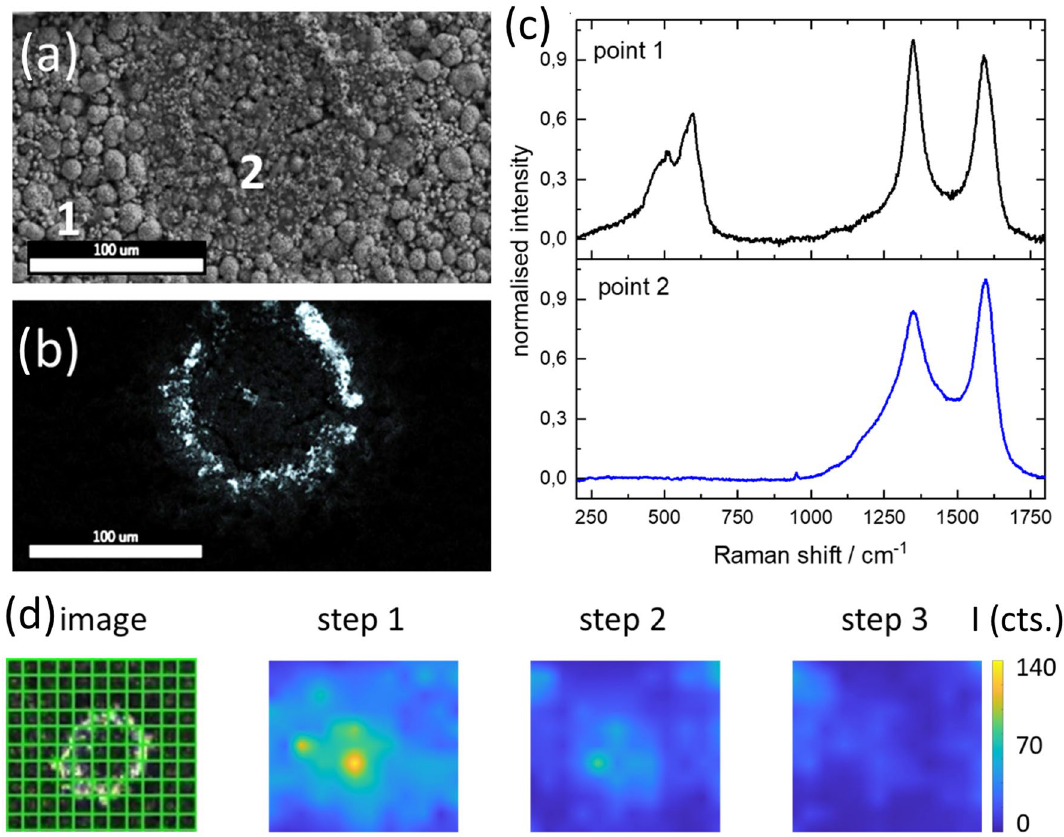
Figure 8. ( a ) SEM image of a local degradation NMC backside (contact surface aluminum-NMC) 1) non- degraded area, (2) degraded area; ( b ) EDX mapping of aluminum; ( c ) Raman spectra of point 1 and 2 d) LIBS analysis of a crater of the NMC backside for aluminum @ 396.15 nm, step means ablation step, size of mapped area 200 µm × 220 µm, the color bar displays the color associated with the absolute intensity (I in